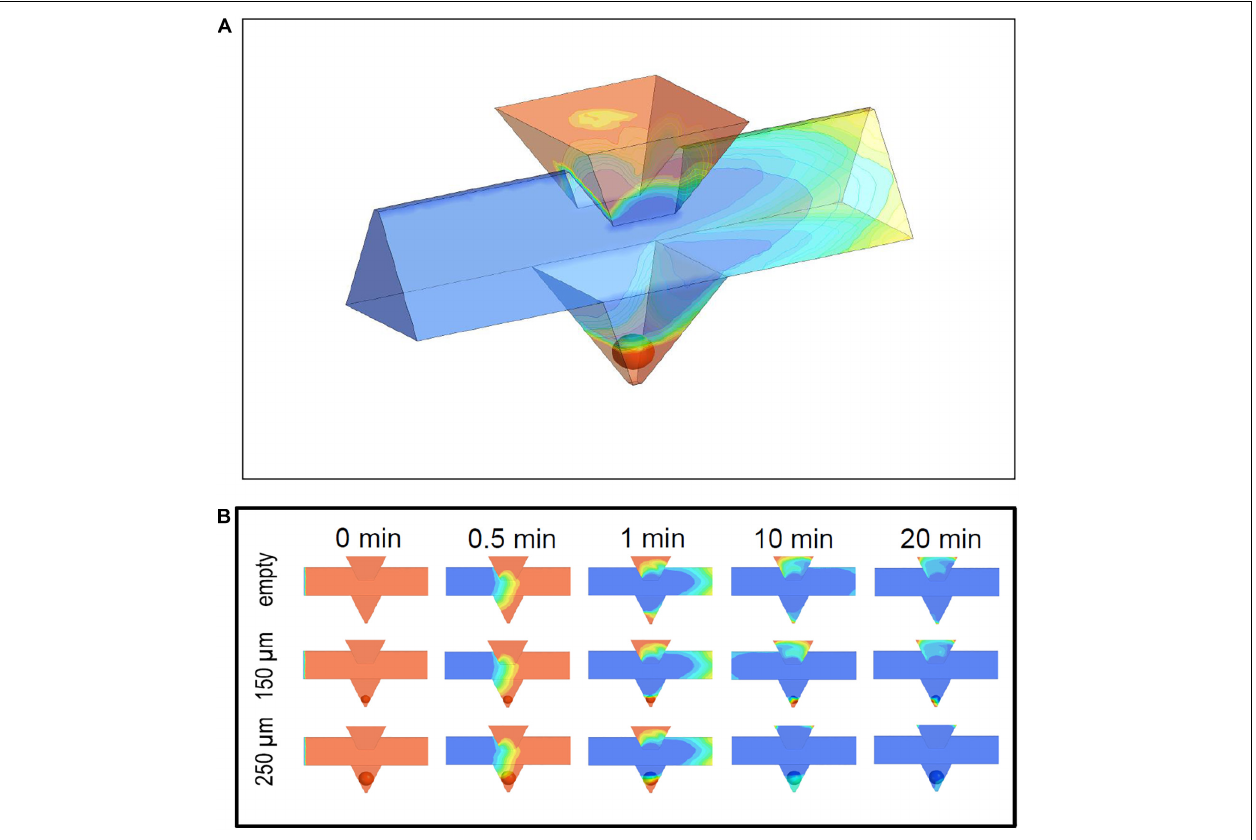
FIGURE 4 | Simulation of medium exchange in the microfluidic system at 37 ◦ C. (A) 3D view of the microchannel and the pyramidal well containing an islet of 150 µ m diameter. The time point is 1 min after the new medium (blue) has entered the microchannel and displaces the pre-existent medium (red). The upper part of the islet has just got into contact with the new medium. The pre-existent medium in the inlet is completely separated from the islet. (B) Time sequence of the fluid exchange, shown for the longitudinal section at the centreline of the microchannel and the well. The pre-existent medium (red) is displaced by the new medium (blue) at a pump rate of 40 µ l per min. The time point 0 is set when the new medium is 1 mm away from the well. The upper row gives the results for the empty system, the middle row for an islet of 150 µ m diameter, and the lower row for an islet of 250 µ m diameter. The exchange velocity is influenced by the occupation of the well and by the size of the islet within the